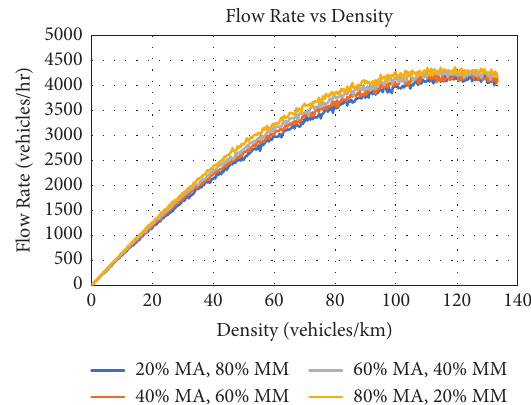
Figure 29: Flow rate vs. density fundamental diagrams for different compositions of MA and MM.